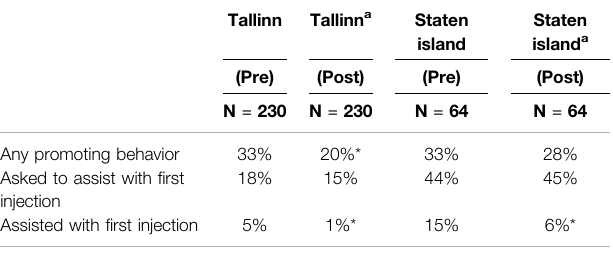
TABLE 3 | Changes in outcomes for targeted